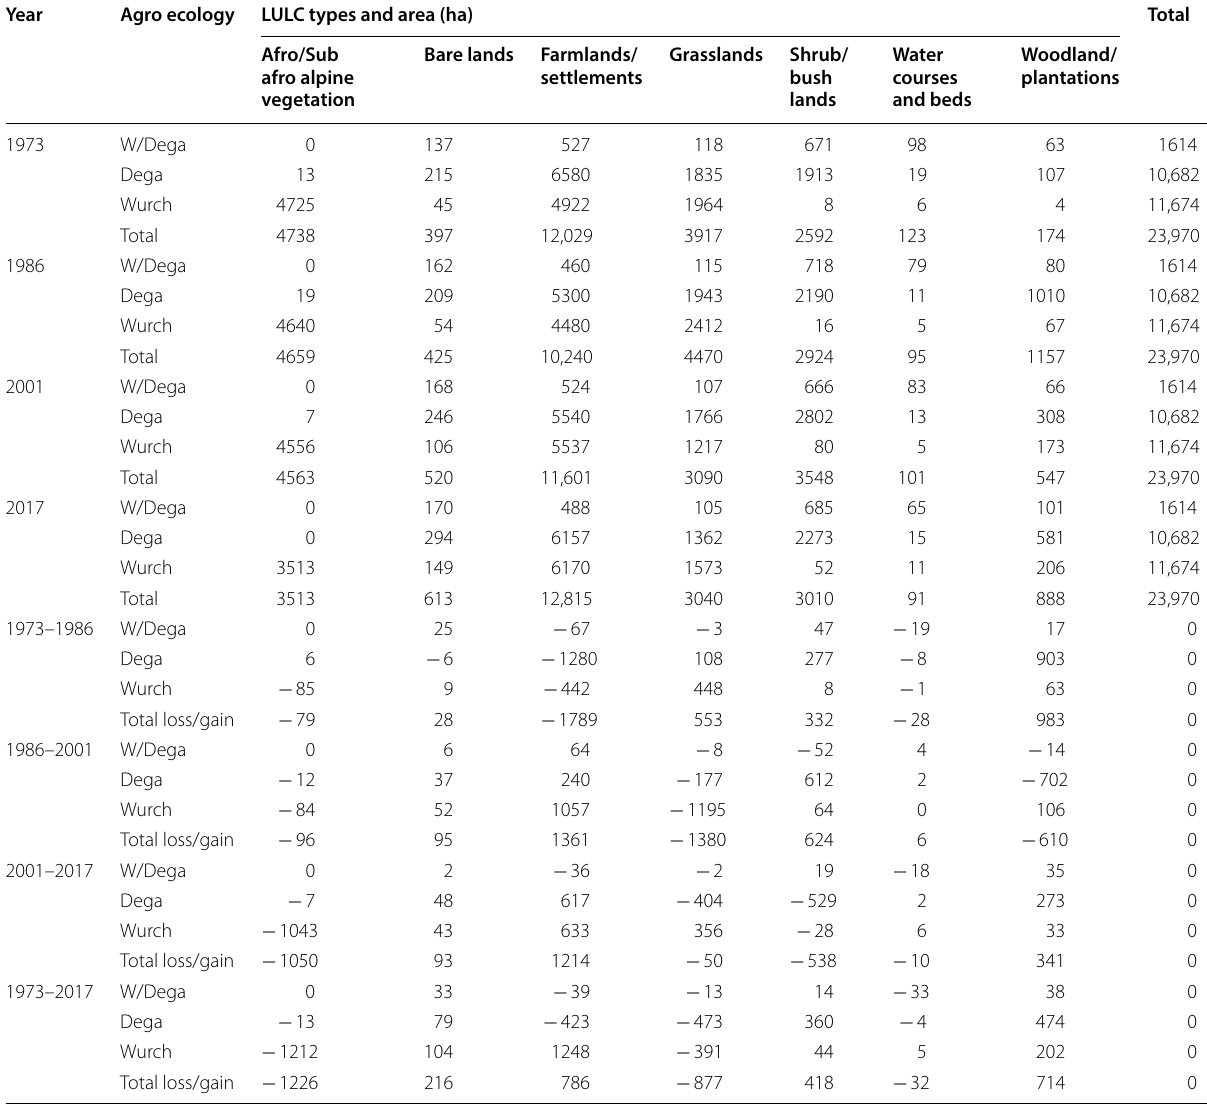
The positive sign indicate expansion in size, while the negative sign show shrinkage in